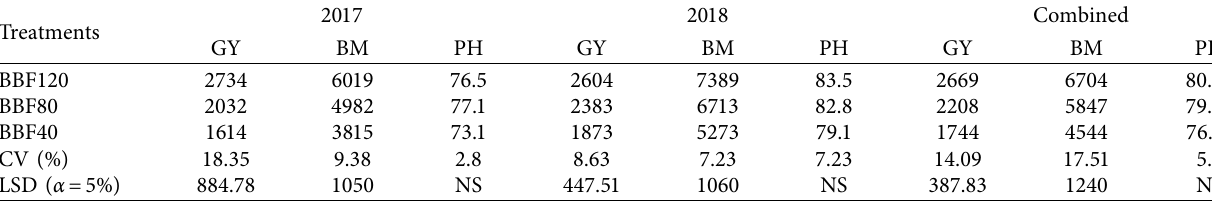
Table 3: Grain yield (kg/ha), biomass (kg/ha), and plant height (cm) of 2017/18 and combined results. Treatments